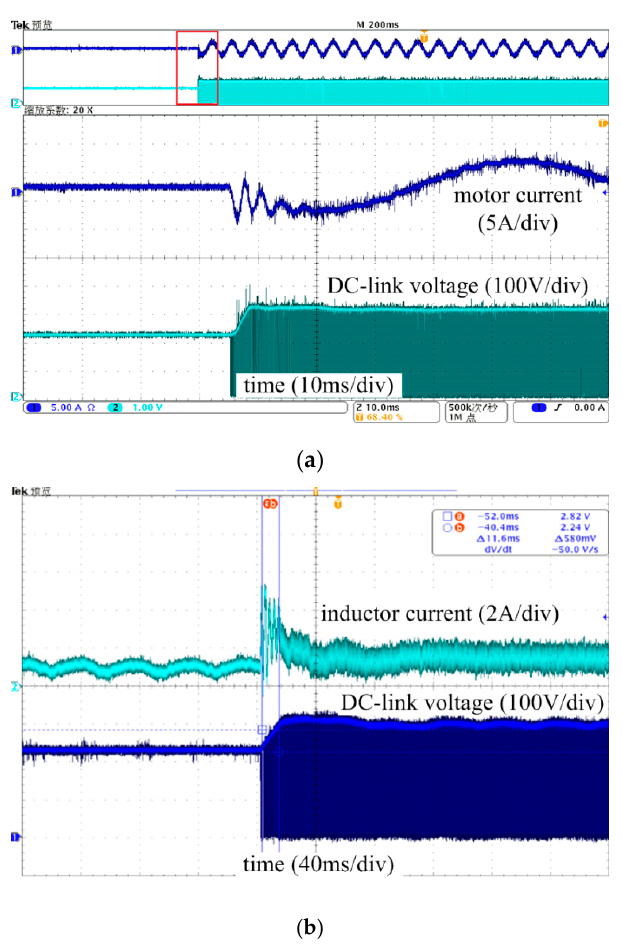
Figure 6. Transient waveforms in starting period: ( a ) Motor current and DC-link voltage; ( b ) Inductor current and DC-link voltage.